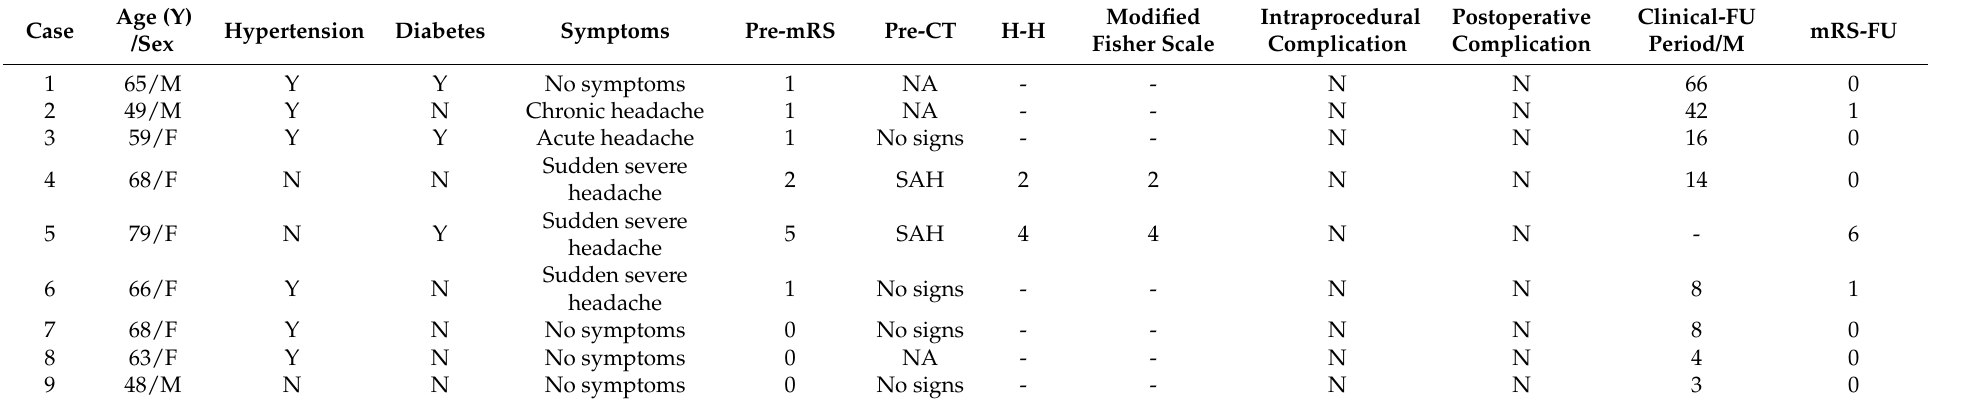
Table 1. Patients’ Demographics.